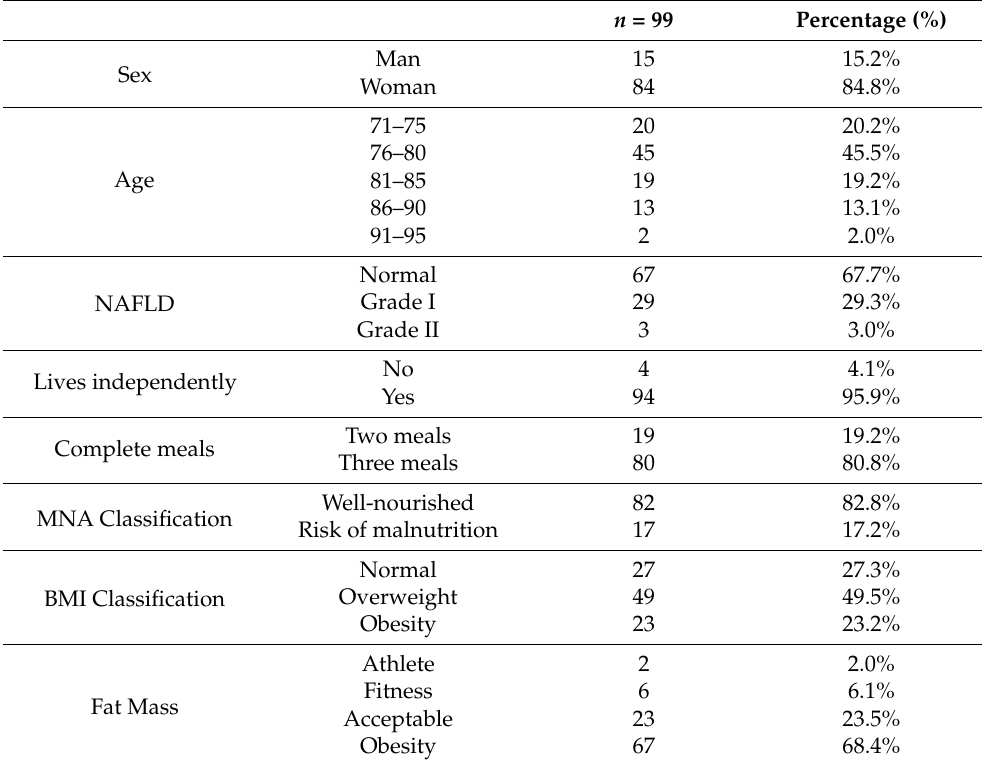
Table 1. Characteristics of the